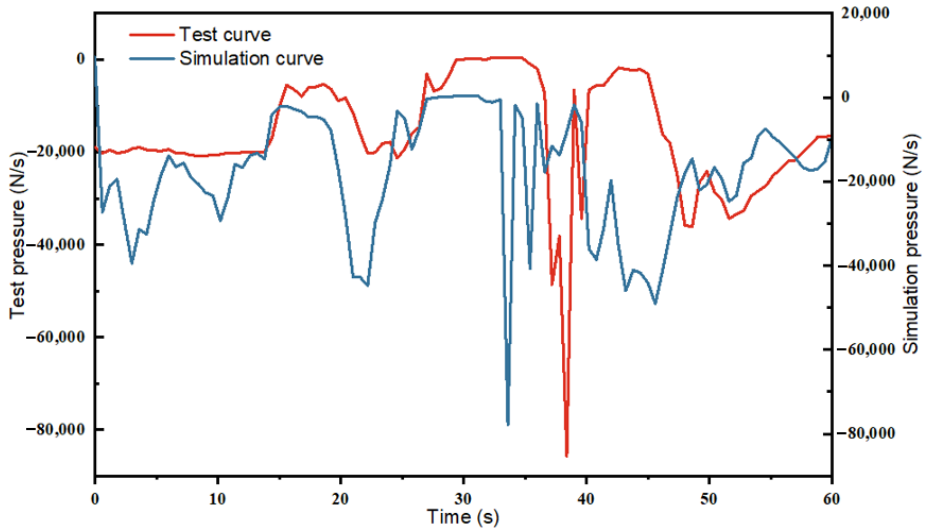
Figure 10. Test result curve on tan30° slope.